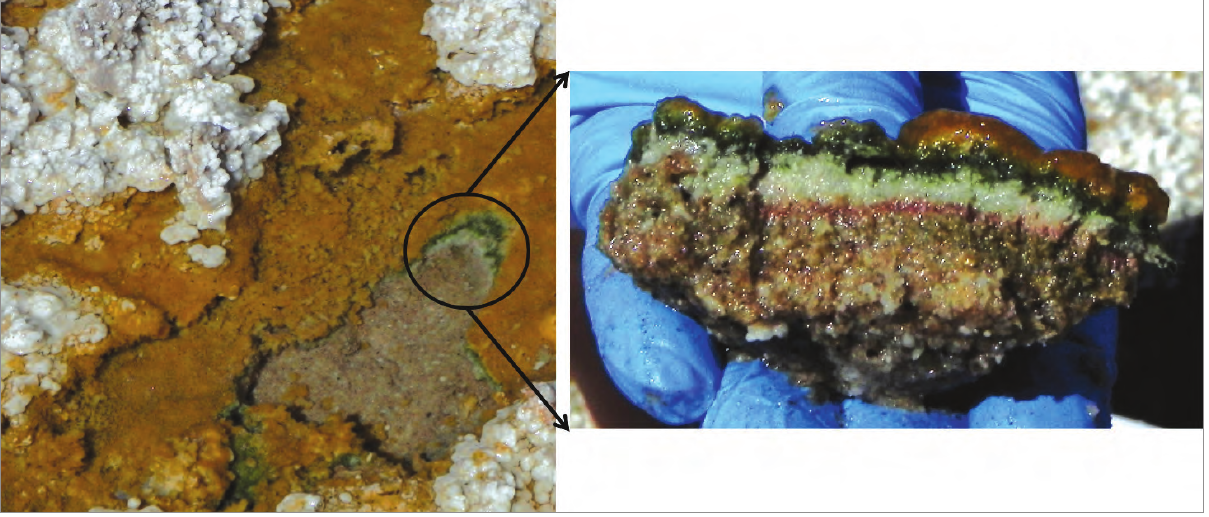
Figure 6: A microbial mat from a hypersaline stream, showing stratified biomass of microorganisms embedded in extracellular polymeric and mineralised materials. Light penetrates only a few millimetres into the mats and oxygen produced by photosynthesis rapidly diminishes with depth. Turnover of carbon fixed in the upper portion of the mats is affected by fermentation processes and sulphate reduction deeper in the mat.